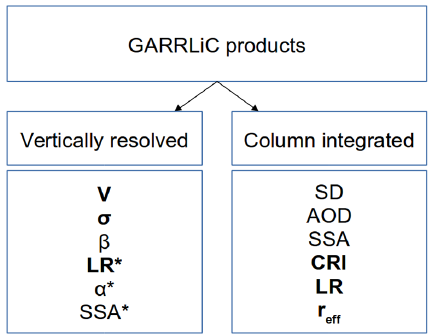
Figure 1. GARRLiC products derived by using single (unmarked) or double (both unmarked and marked *) mode inversion. The latter can be applied only to multi-wavelength lidar data. Common prop- erties, which are compared in this work, retrieved using GARRLiC, LIRIC, and Raman and regularization are indicated by bold